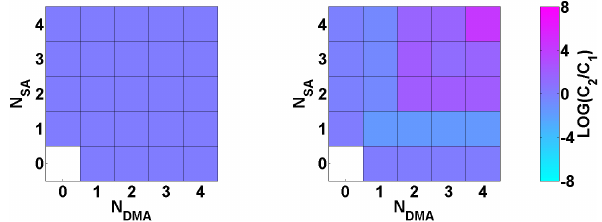
Fig. 6. The differences in cluster concentrations when the collisions resulting in clusters outside of the system are either (1) permitted or (2) prevented. The left panel is for the differences at the standard monomer concentrations, while the right panel is for high concen- trations. The colour scale gives the base-10 logarithm of the ratio of the concentrations in these two cases.